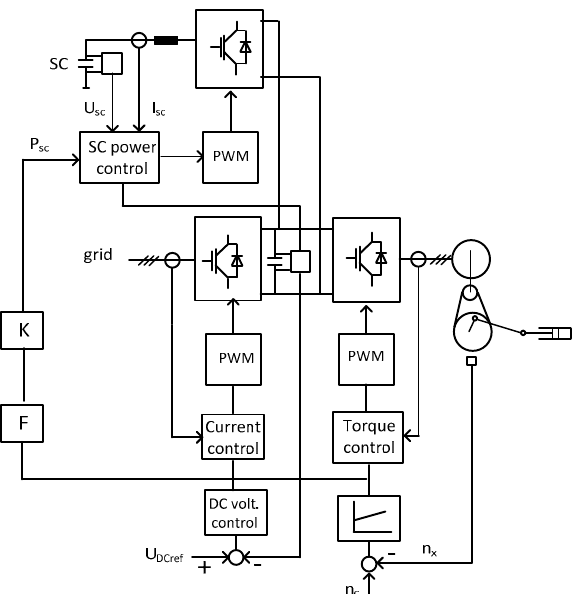
Figure 18. Schematic diagram of the electric drive system with active power compensation circuit.